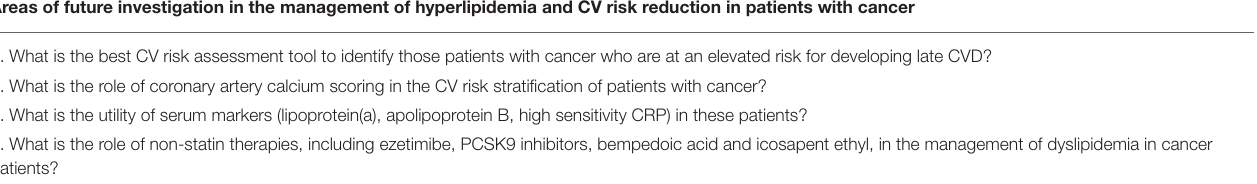
TABLE 5 | Future areas of investigation for mitigating cardiovascular risk in patients with cancer. Areas of future investigation in the management of hyperlipidemia and CV risk reduction in patients with cancer